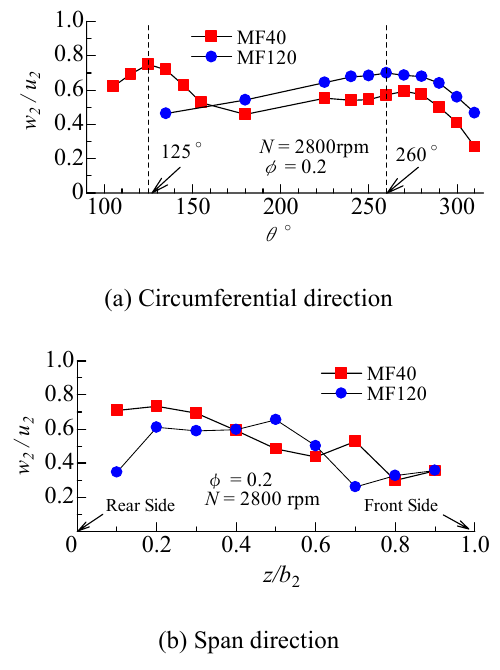
Fig.15 Distribution of the relative velocity in the fan